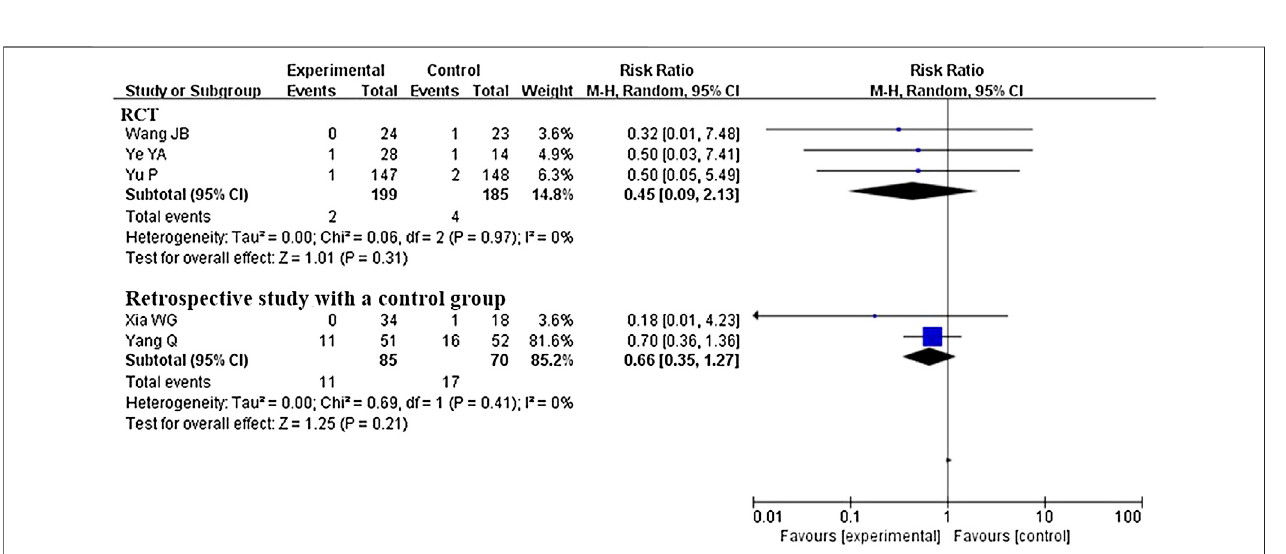
Frontiers in Pharmacology |